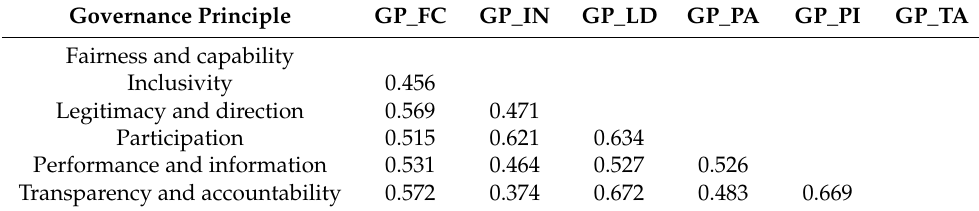
Table 9. Model discriminant validity: heterotrait heteromethod (HTMT).